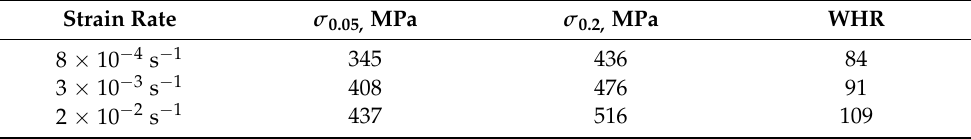
Table 2. Results of mechanical tests.